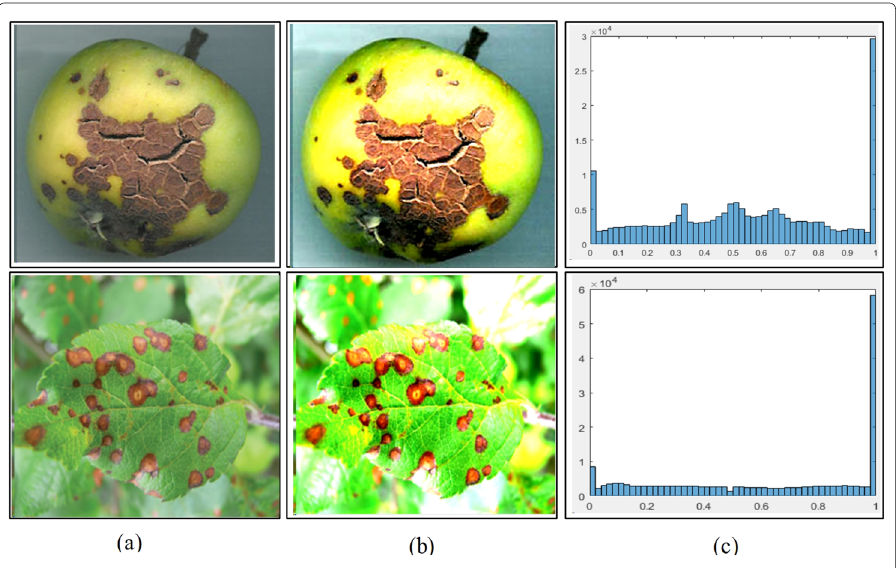
Fig. 4 Proposed contrast stretching results. a Original image. b Final enhanced image. c Histogram